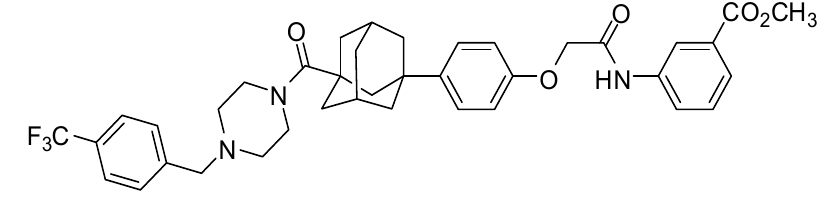
Figure 1. Structure of LC478.